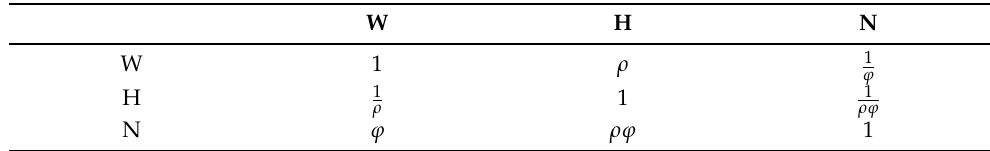
Table 1. Importance matrix of criterion